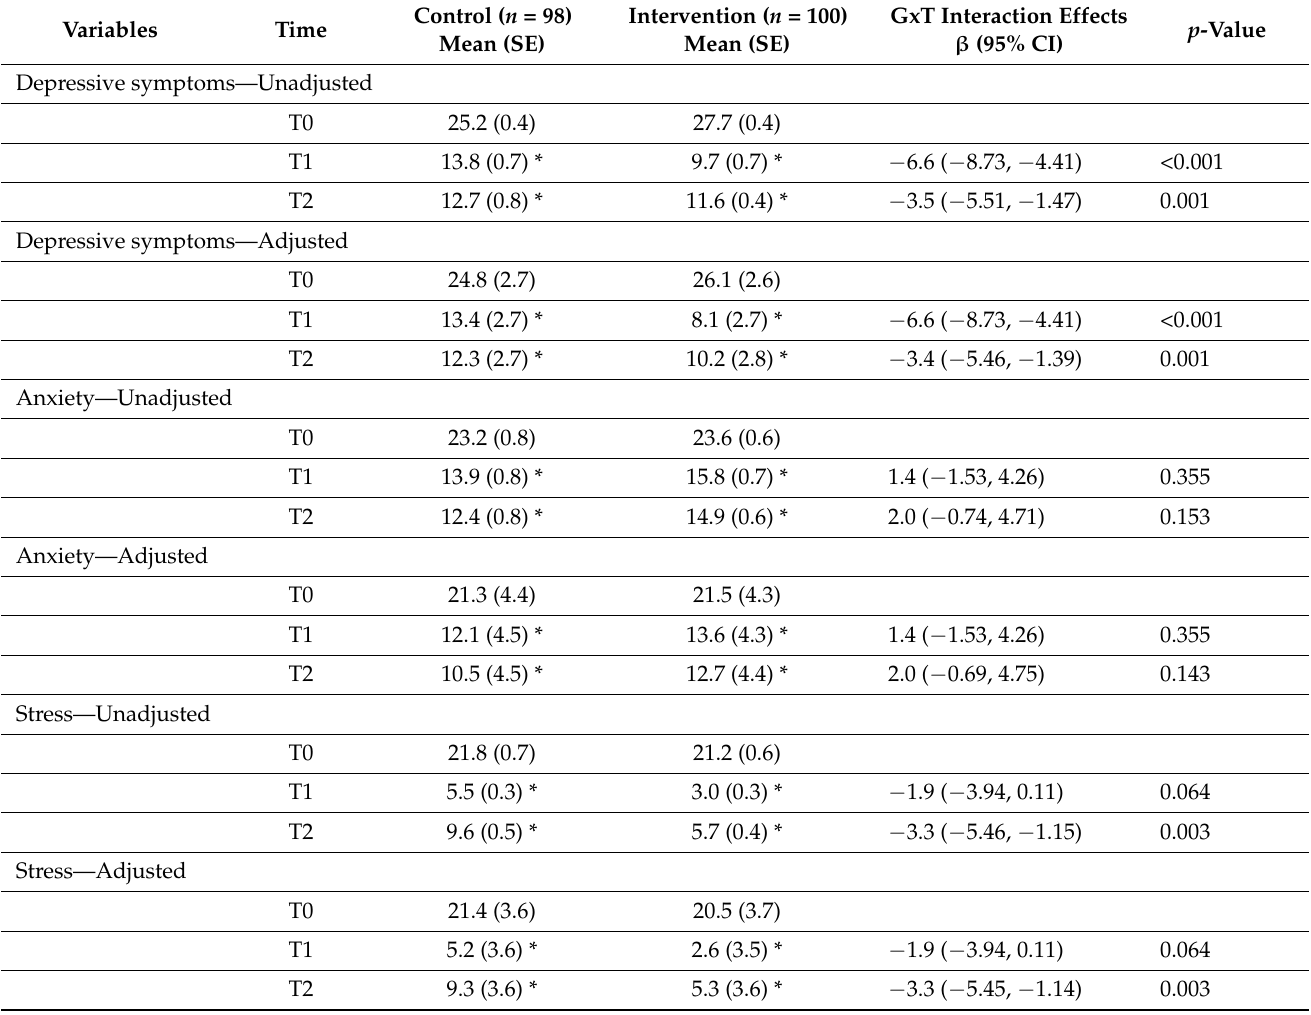
Table 4. Effects of the ACD intervention on depression, anxiety, and